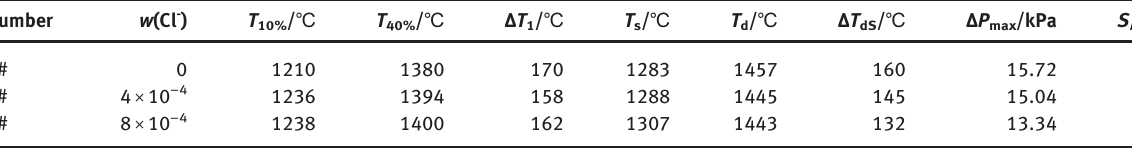
Table 3: Test schemes and results.